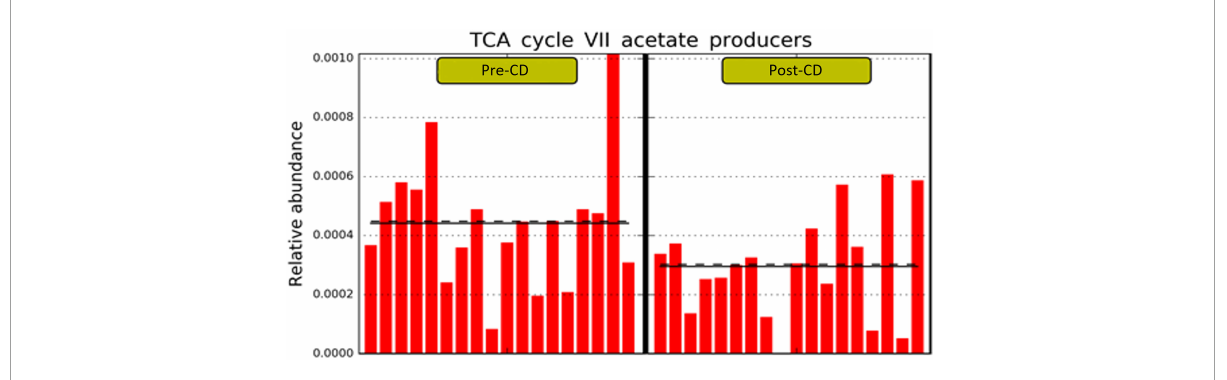
FIGURE5 Statistically significant different predicted pathway with LDA score > 2.0 between pre- and post-CD. LDA, linear discriminant analysis; CD, control wheat diet.